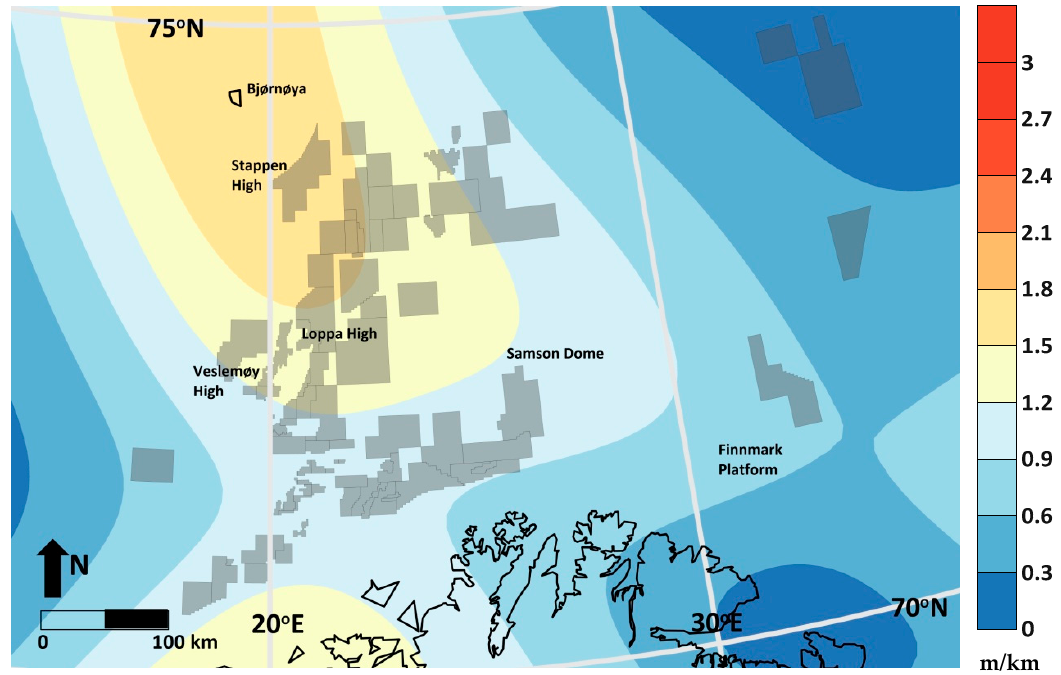
Figure 8. The isostatic tilts for lithosphere thickness of 70 km.